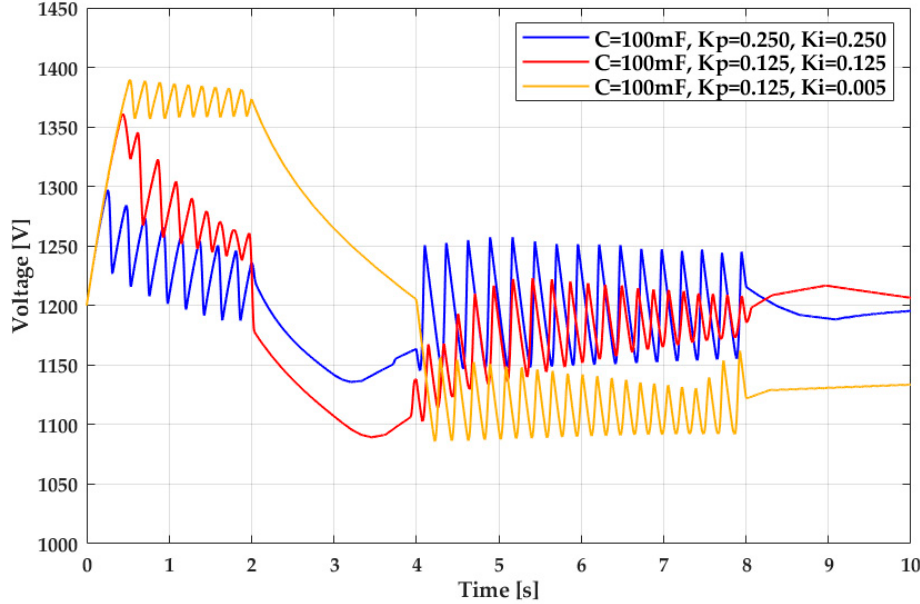
of C DCbus = 10 mF (small value).